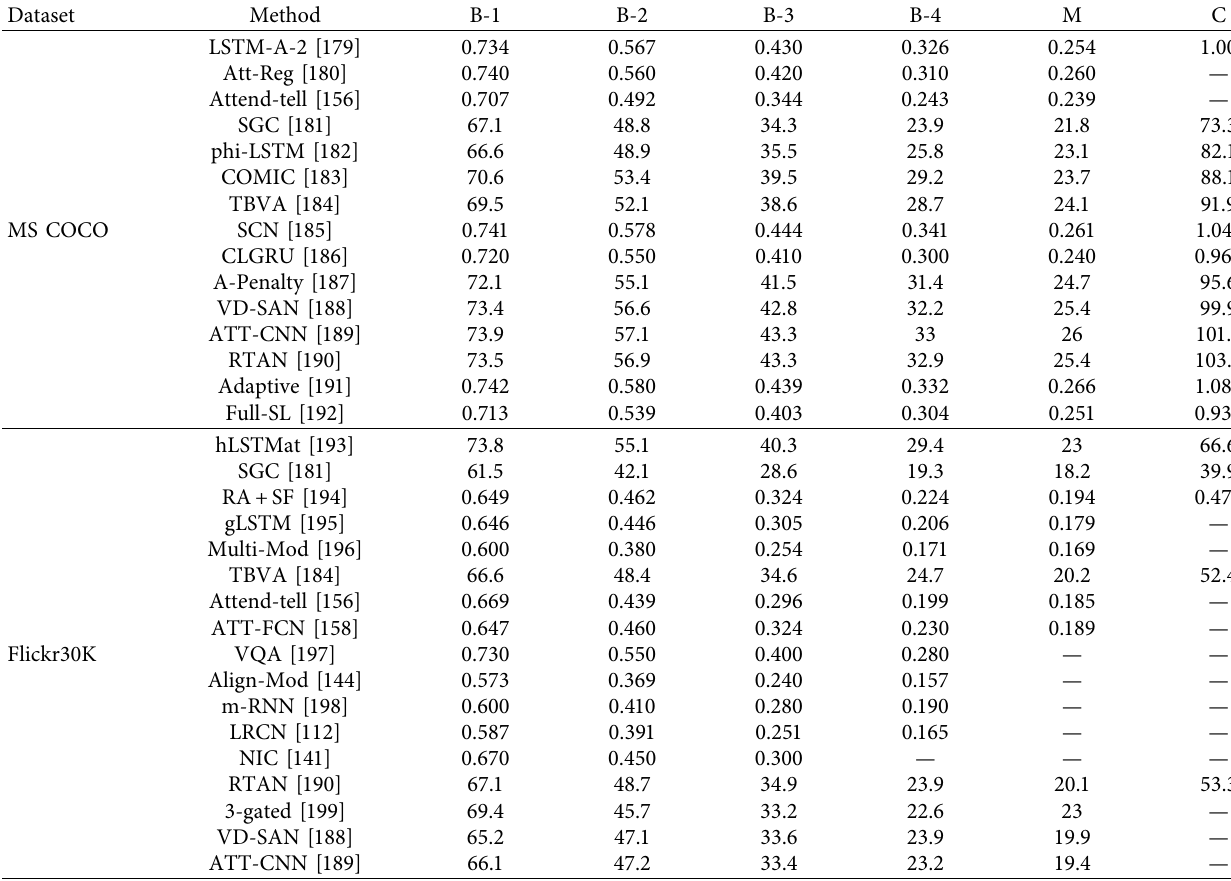
Figure 7: Image pair difference annotations of the Spot-the-Diff dataset [166]. (a) The blue truck is no longer there. (b) A car is approaching the parking lot from the right. Table 2: Class pixel label distribution in the CamVid